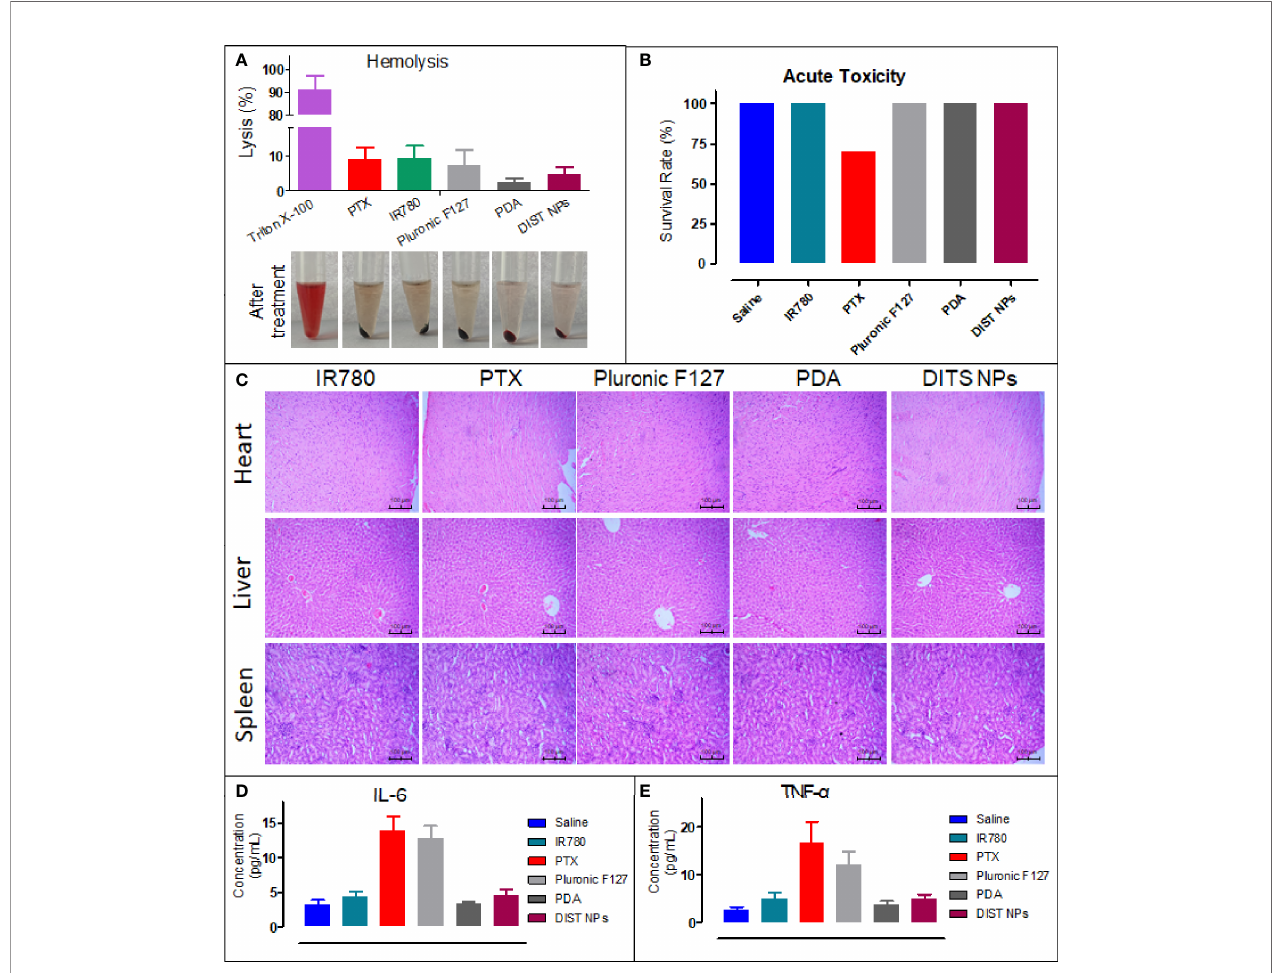
FIGURE 5 | In vivo toxicity evaluation of the DIST NPs. The hemolysis test results of the DIST NPs. Pluronic F127 is the main surfactant in preparation of the DIST NPs. Therefore, the toxicity should be evaluated (n = 3) (A) . The in vivo acute toxicity test results of the DIST NPs on the BALB/c mice (B) . The pathological analysis of the DIST NPs and the main components to the heart, liver, and kidney (C) . The effects of the DIST NPs and its components to the main in fl ammatory factors in vivo (n = 4) (D, E)